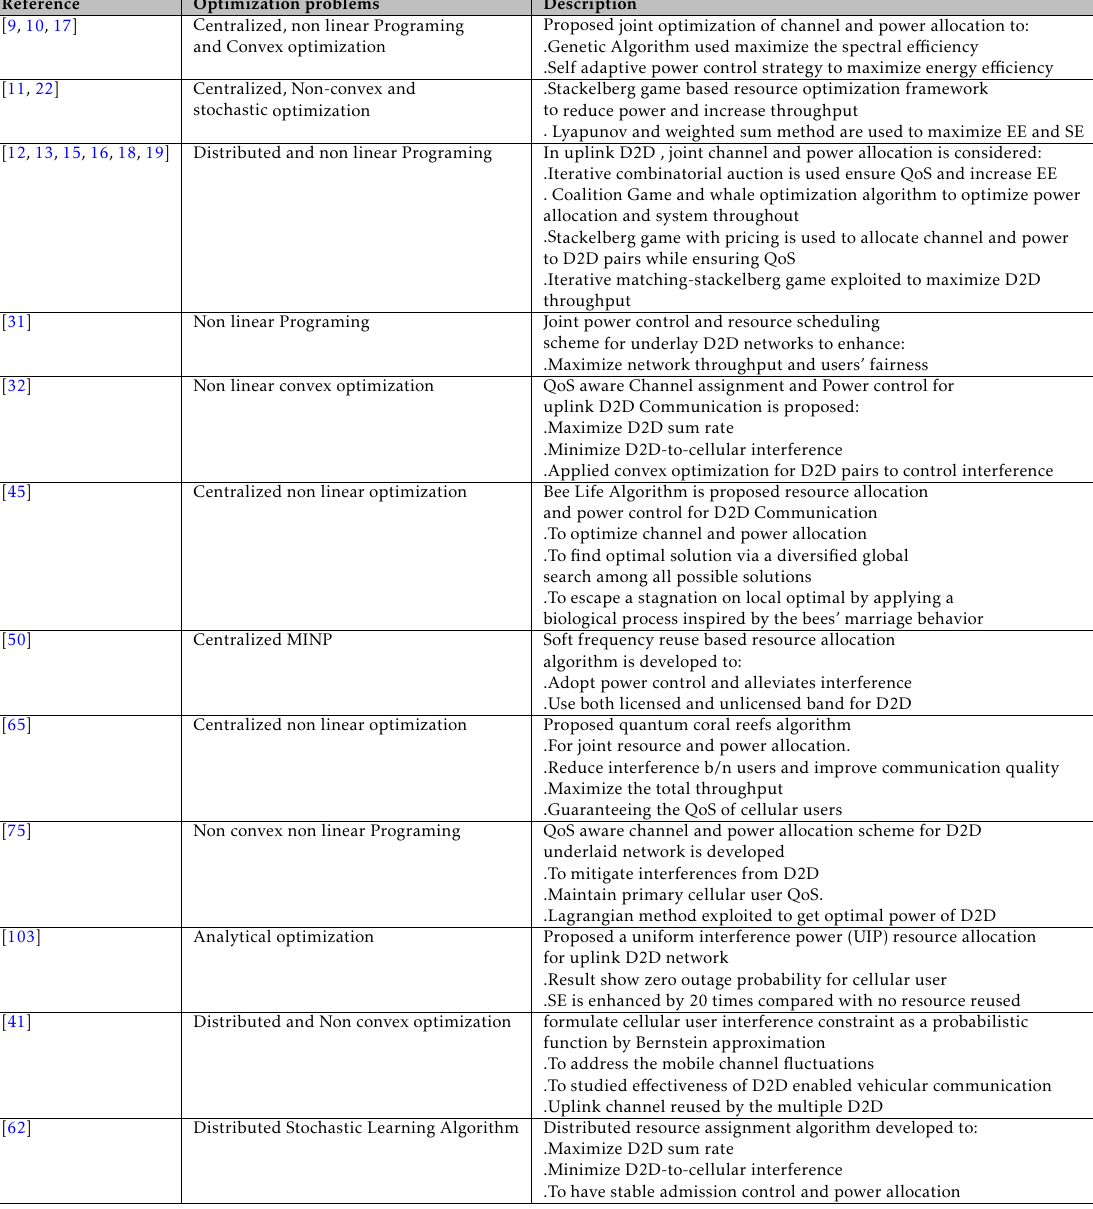
Table 4. Centralized and Discentralized Resource Allocation in D2D